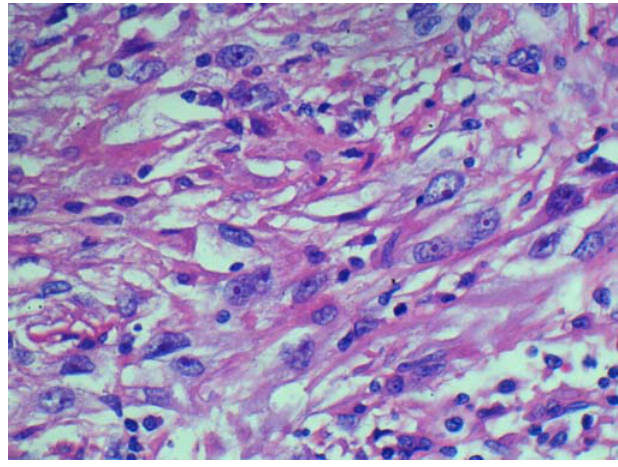
FIGURE 2 . Microscopic examination at high power demonstrates Fuhrman Grade 3